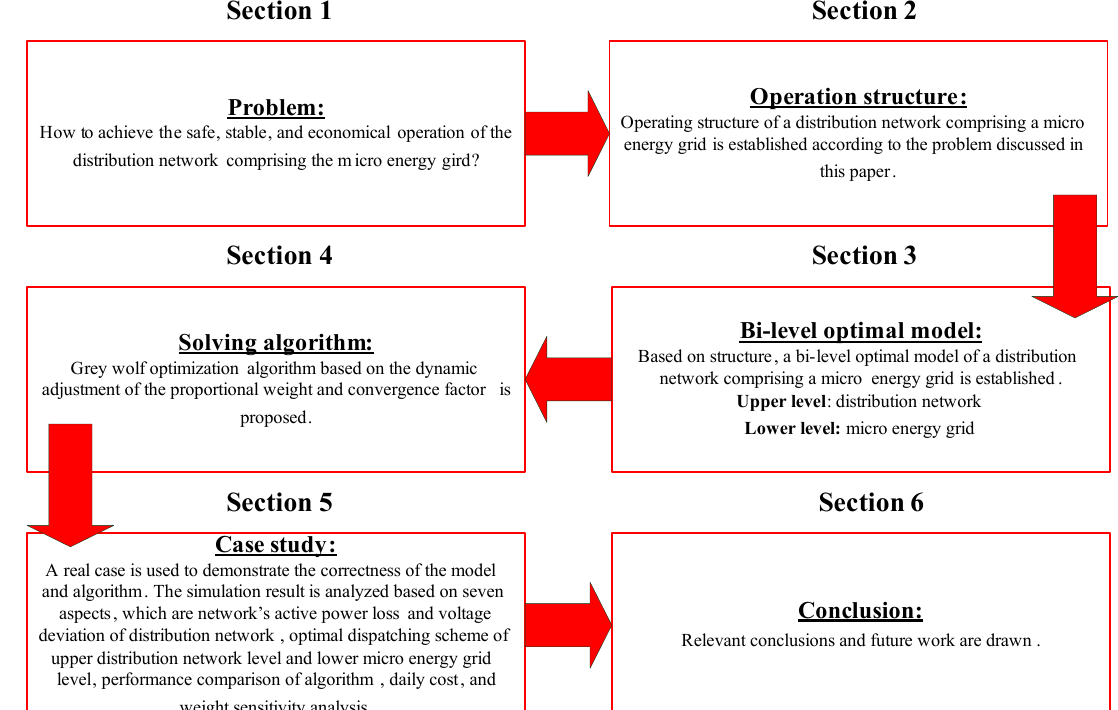
Figure 1. General workflow for the optimal operation of the distribution network comprising the micro energy grid, based on the improved grey wolf optimization (GWO) algorithm.